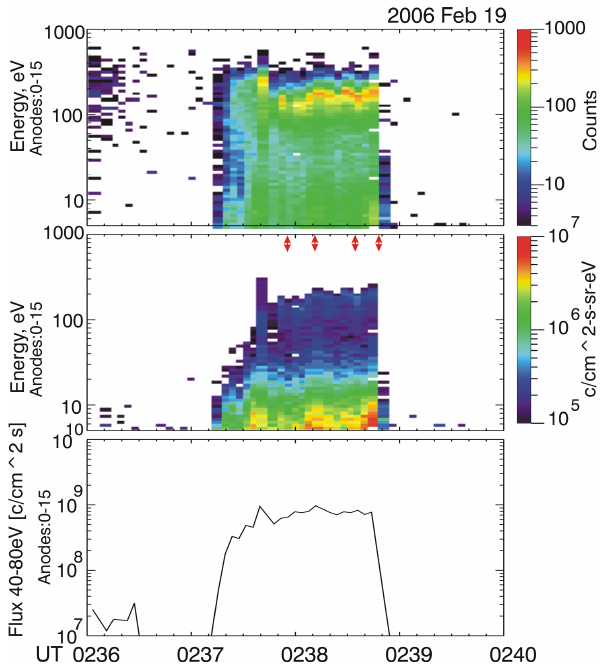
Fig. 11. Spectrogram of electron fluxes measured by ELS- ASPERA-3 during the UV observations of aurora and total fluxes of electrons (40eV <E< 80eV). The top (middle) panel shows spectra as a function of C(E) ( j(E) ), respectively. The peaks in C(E) vis- ible above 100eV are almost vanish when plotting differential flux j(E) .